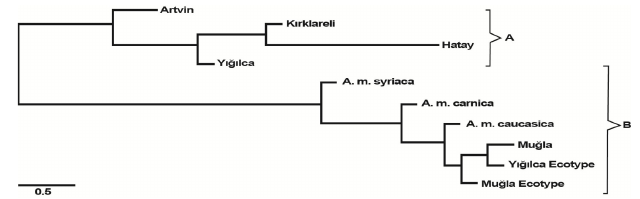
Fig 7. The classification of the honeybee population based on UPGMA dendogram. A: isolated native area, B: common garden